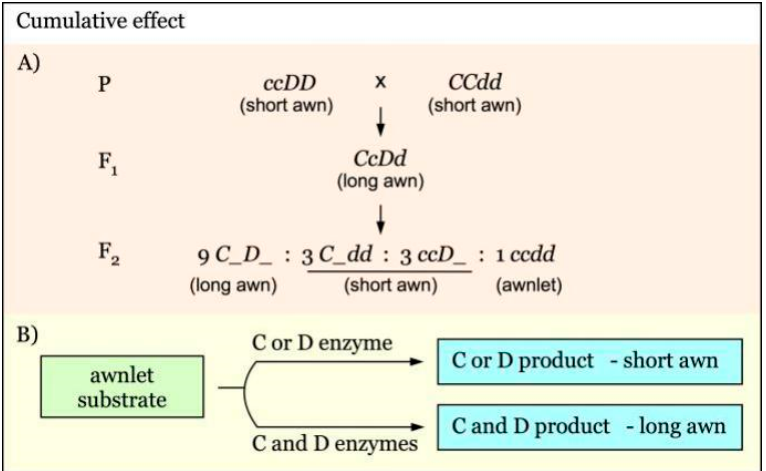
F 2 segregation ratio of 9:6:1 for long to short to awnlet would be expected. C or D enzyme alone could convert awnlet to short awn phenotype. When both of them are present, their products are additive, giving rise to the long awn phenotype (Figure 4B).